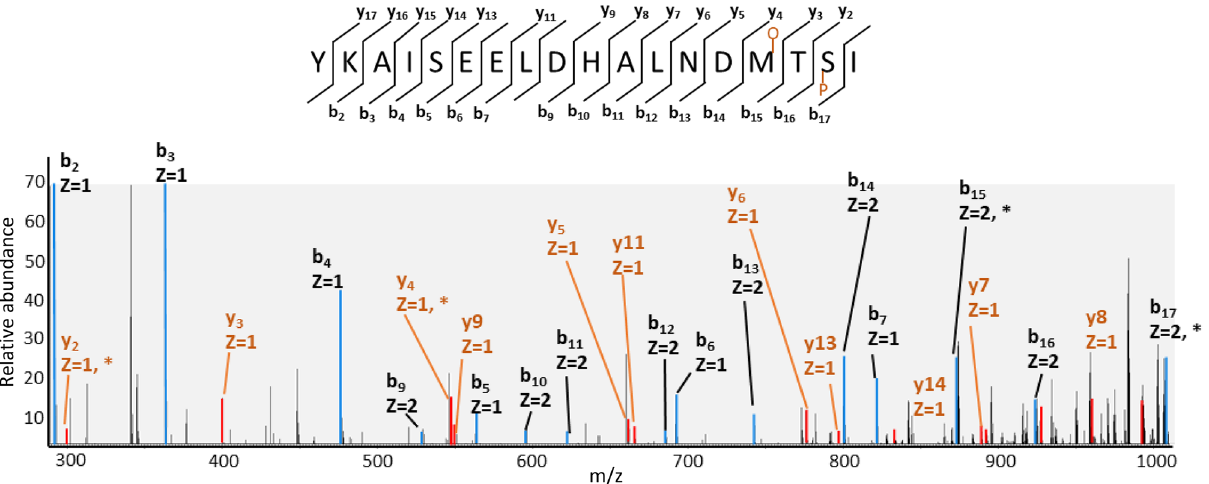
Figure 4. Fragmentation spectra of peptide with two PTMs: phosphorylation and oxidation. Highlighted peaks represent peptide fragments. b-ions show fragments from the peptide N-terminus side (blue) and y-ions show fragments from the peptide C-terminus (orange). Fragments with modifications are highlighted with *: b15, b17, y2 and y4. The peptide is oxidated on methionine and phosphorylated on serine. The inset figure at the top shows all fragment ions